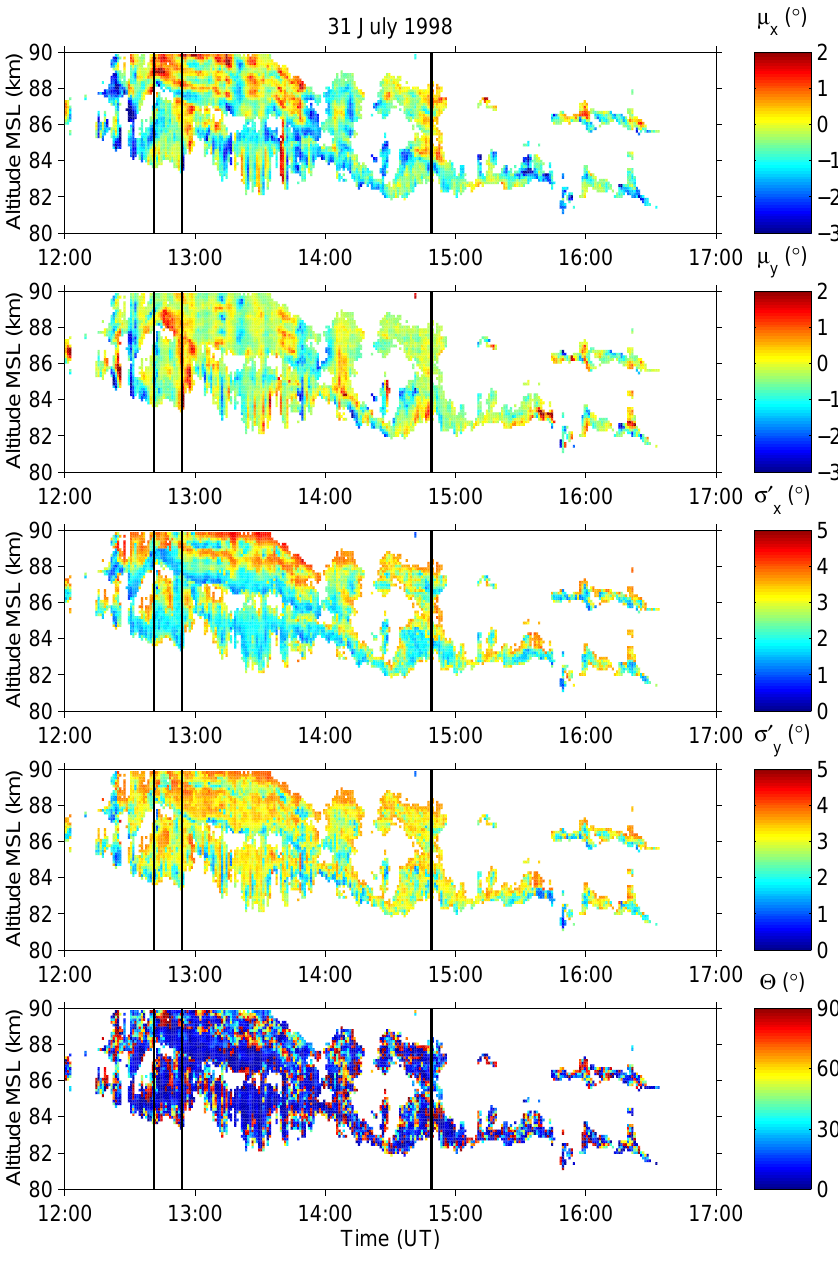
Fig. 3. Range-time pseudocolor plots of MAOA estimates ( µ x and µ y ); the half- widths of the brightness distribution ( σ 0 x and σ 0 y ); and the rotation angle ( 2 ). See text for a description of these quantities. The black vertical lines are used to flag times that have been selected for closer